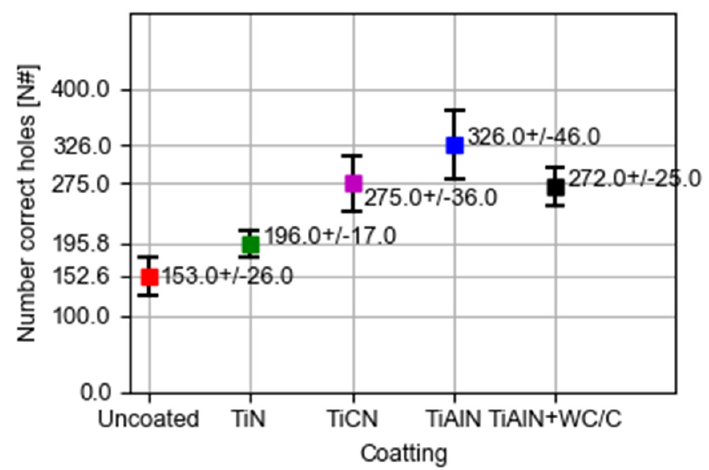
Figure 5. Tool life comparison on different coated taps.